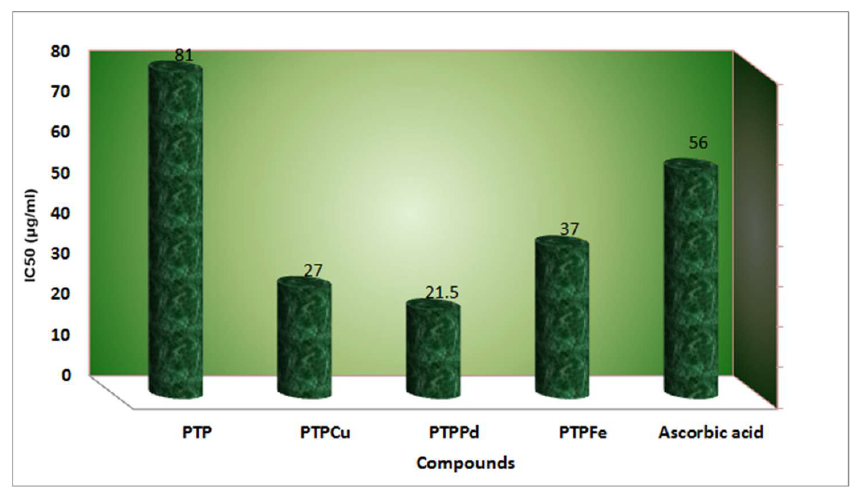
Figure 12. Inhibition tendency of studied PTP (99) ligand & its chelates (100–102). Reproduced from the permission of ref. [157].